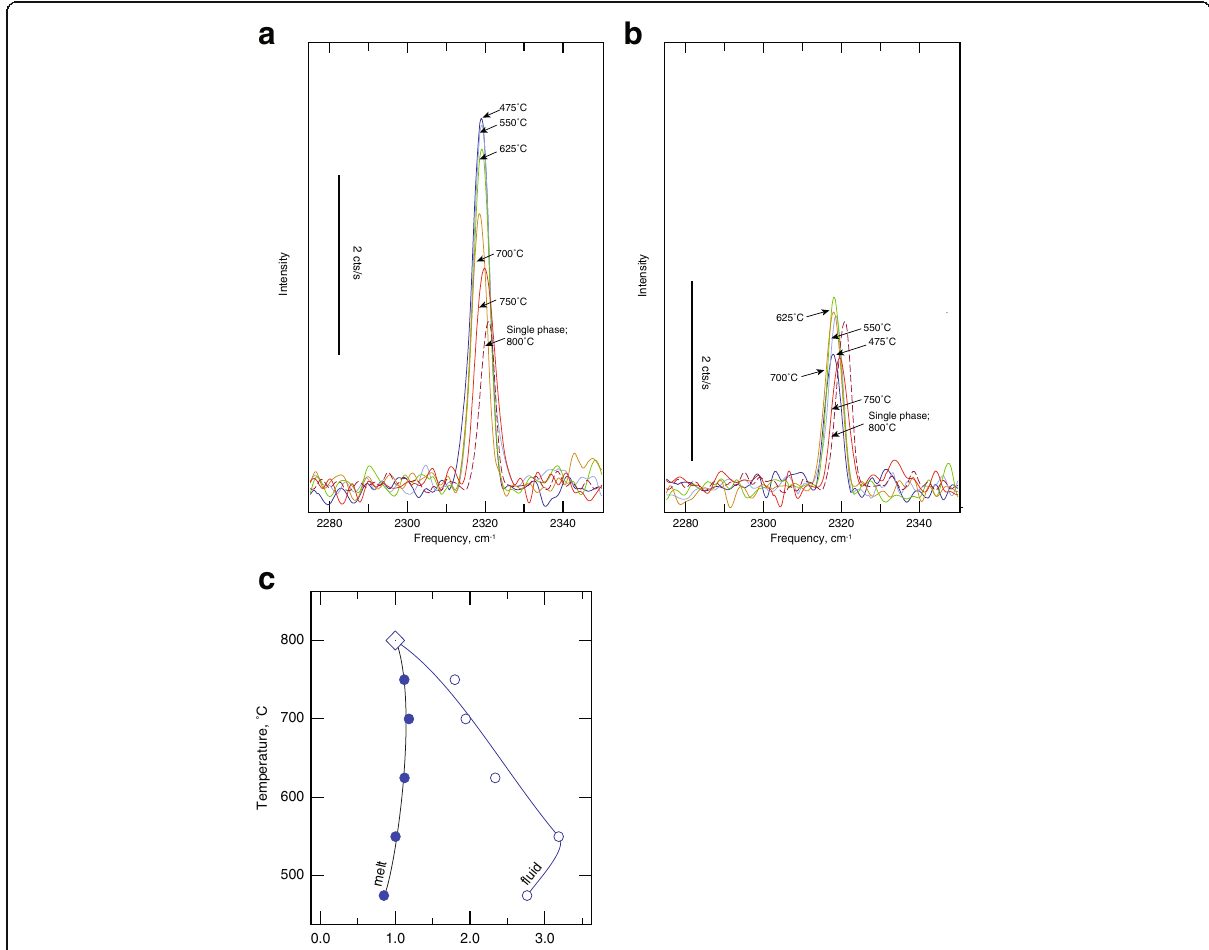
Fig. 6 Raman spectra of coexisting fluid and melt in the high-frequency region of fundamental N=N vibrations. a Spectra of fluid at temperatures indicated (corresponding pressures can be found in Table 1). b Spectra of coexisting melt (corresponding pressures can be found in Table 1). The spectra are normalized to the same acquisition time with identical focal plane and with otherwise identical instrumental parameters. c Areas of coexisting melt and fluid normalized to the area of single phase fluid at 800 °C as a function of temperature and